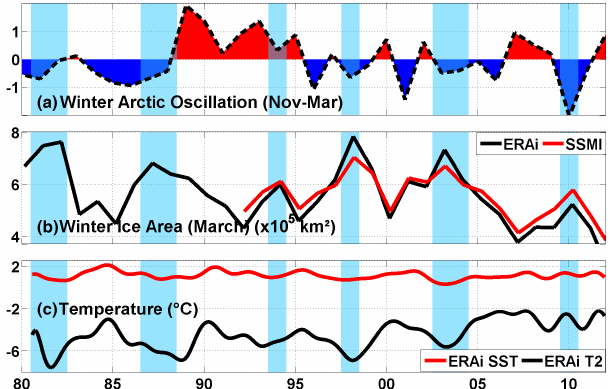
Figure 8. Interannual variations from 1980 to 2011 of (a) winter Arctic Oscillation (November–March) from NOAA. (b) Maximum sea ice extent (March). Black line: ERAi re-analysis, red line: from SSMI. (c) Low-passed (14 months) air temperature at 2m and SST from ERAi re-analysis.